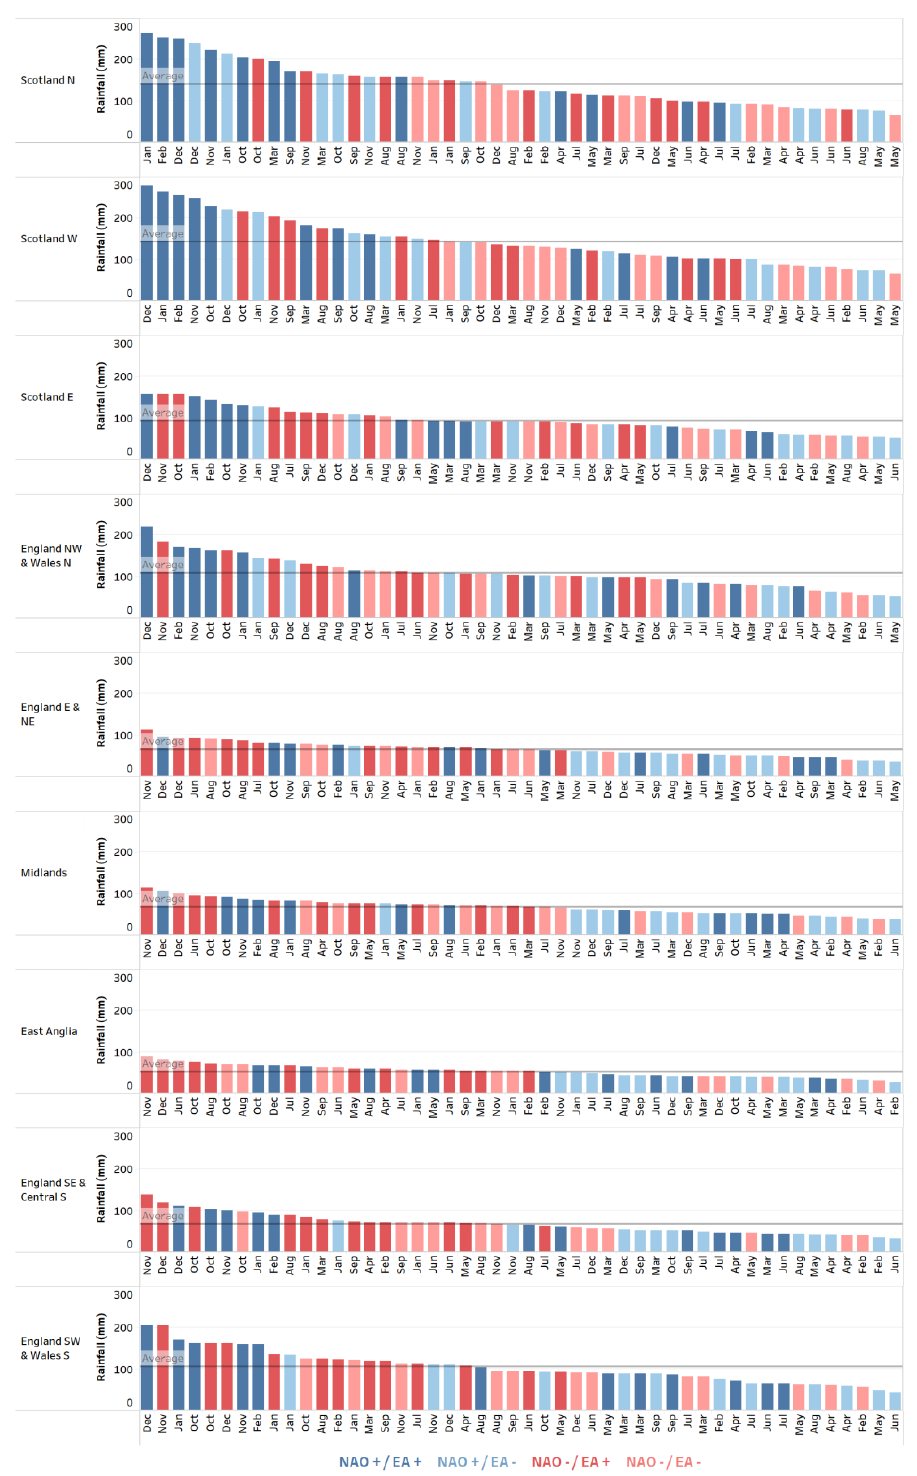
Figure 4. As per Figure 3, however, with the monthly NAO/EA phase combinations ranked in descending order based on the spatially averaged rainfall value. The average line on the individual graphs represents the annual (12-month) average rainfall for the Climate District.